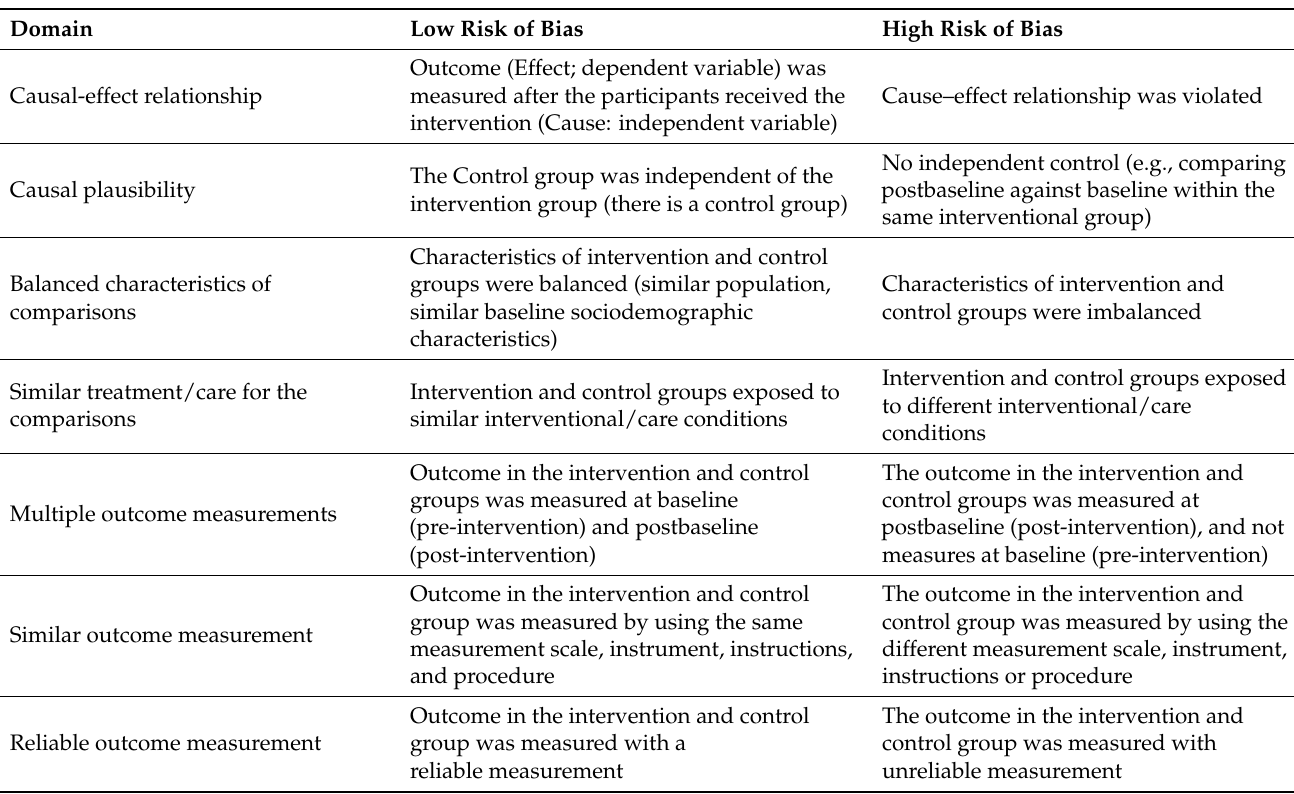
Table A2. Domains of the JBI critical appraisal tools for the assessment of the risk of bias in quasi-experimental